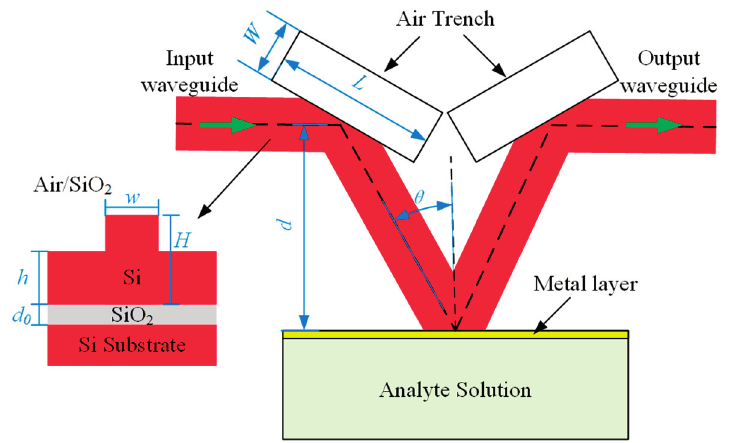
Figure 1. The top view of the waveguide based surface plasmon resonance (SPR) sensor and